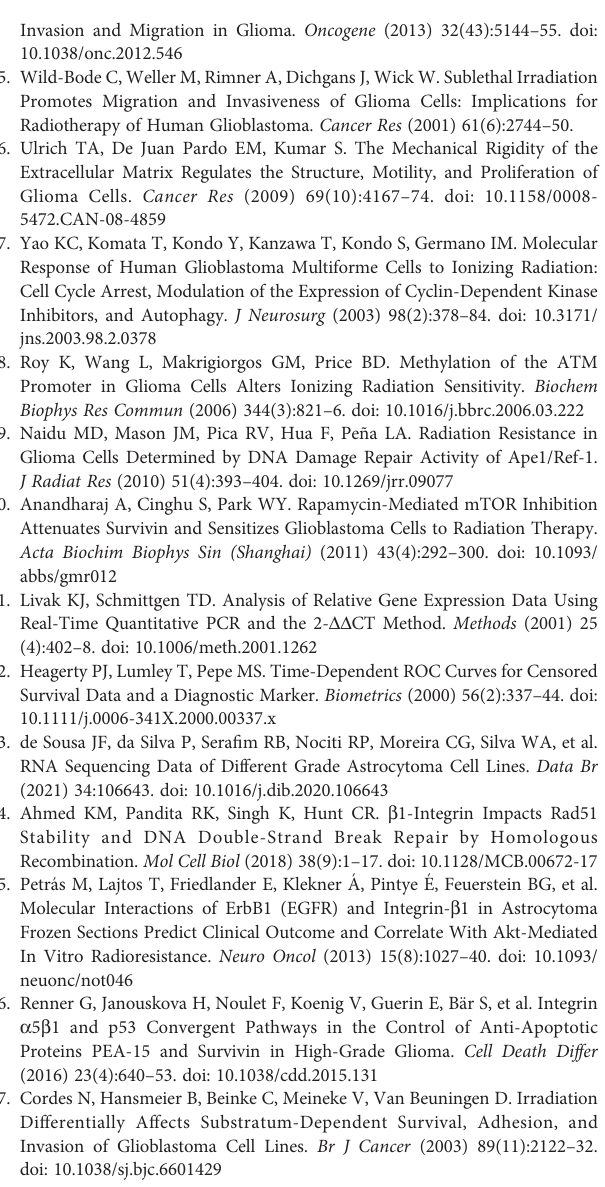
Supplementary Table 1 | Genes identi fi ed as differentially expressed in the comparisons between IR-resistant and sensitive cells. All genes with padj ≤ 0.0001 and log fold change > 2 were selected as differentially expressed in each indicated comparison. Supplementary Table 2 | Enriched KEGG pathways in each comparison of IR- resistant versus sensitive cells. Allgenes with padj ≤ 0.0001 and log fold change > 2 or < -2 of each comparison were subjected to pathway analysis by KEGG. Supplementary Table 3 | Clinical and expression data of LGG patients used in survival analysis. The clinical data of patients from the lower-grade glioma cohort